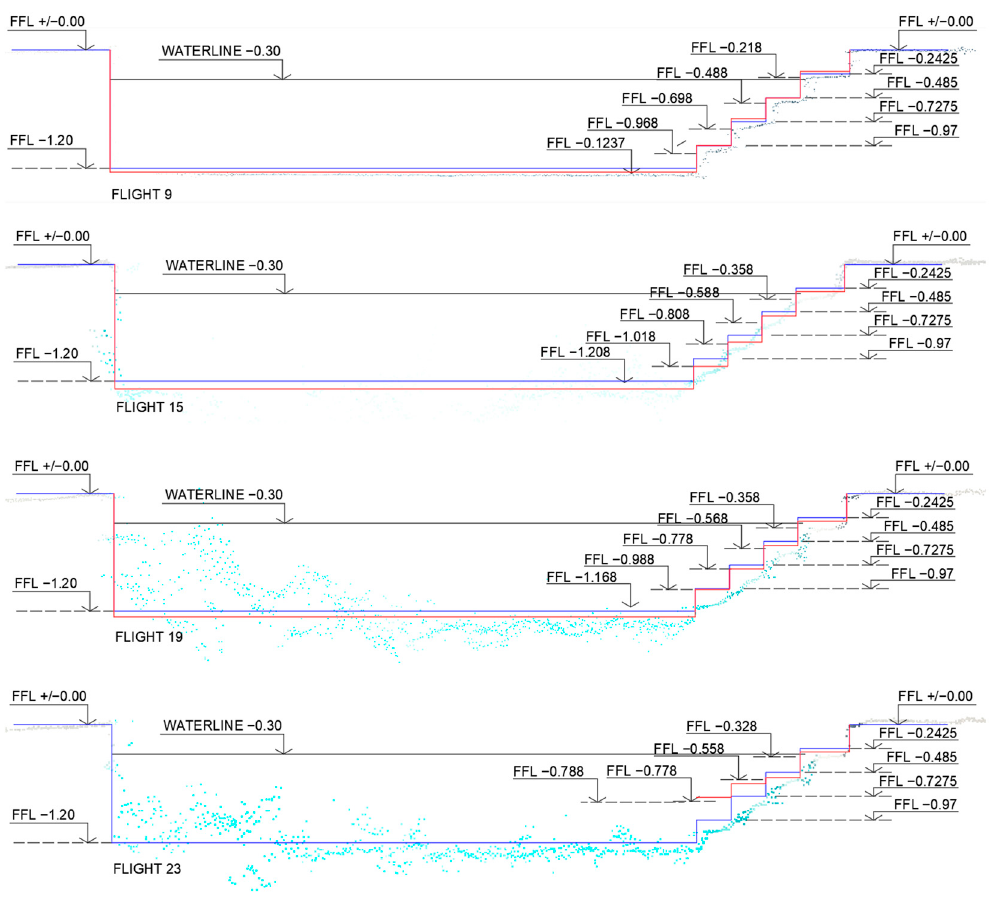
Figure 8. Comparison between the point clouds obtained using a UAV and those obtained from conventional topographic surveys.